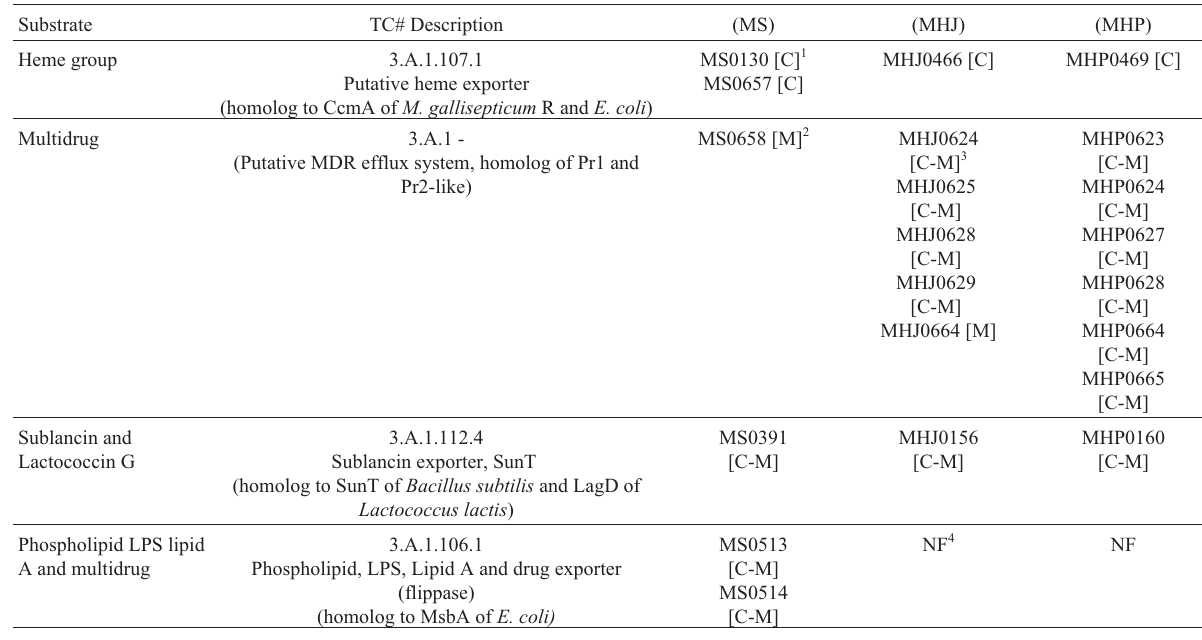
Table 3 - Description of the CDSs related to ABC exporters (efflux systems) in the M. synoviae strain 53 (MS) and M. hyopneumoniae strains J (MHJ) and 7448 (MHP) genomes.